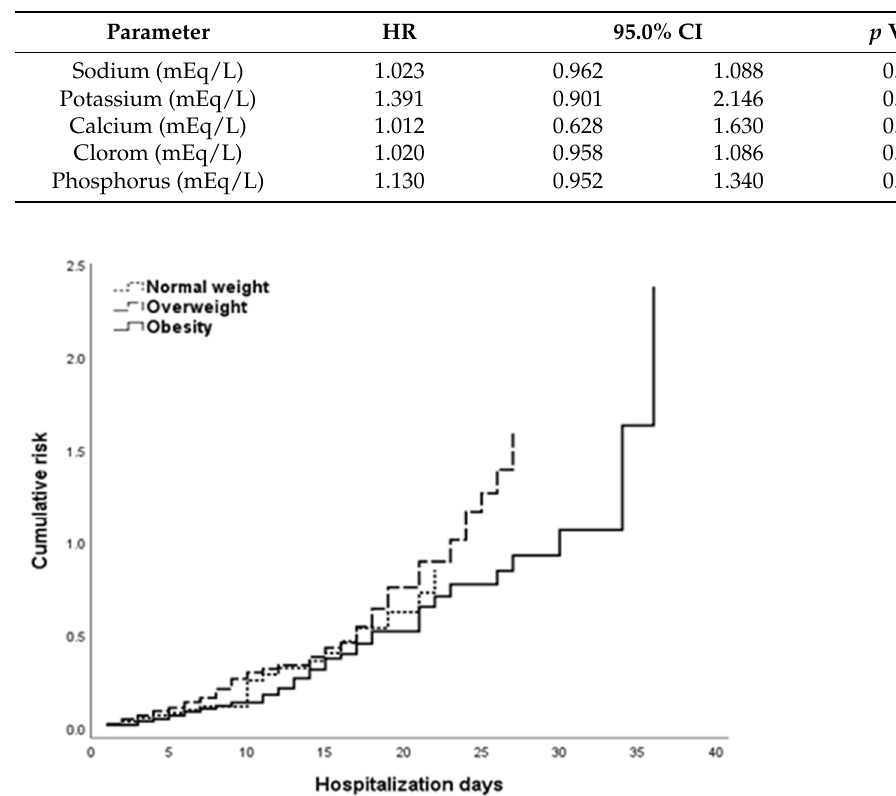
Figure 3. Survival analysis from Cox regression proportional hazards model by BMI distribution in COVID-19 patients. Table 3. Cox regression proportional hazards model with cumulative risk considering renal func- tion and electrolyte status in obese patients with COVID-19. The analysis was adjusted for age and biological sex.